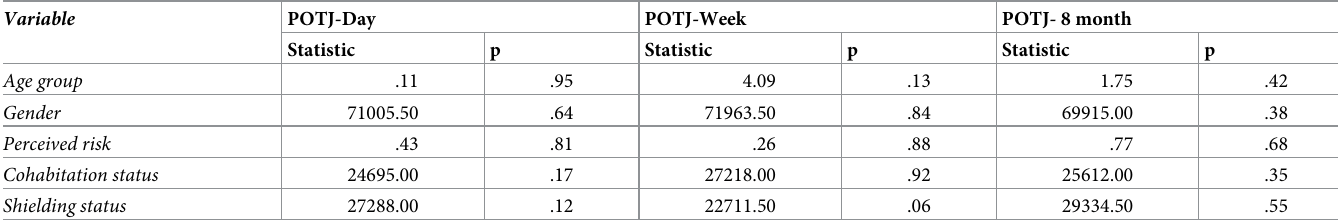
Table 2. Outcomes of the analysis of the effect of demographic factors on POTJ’s.